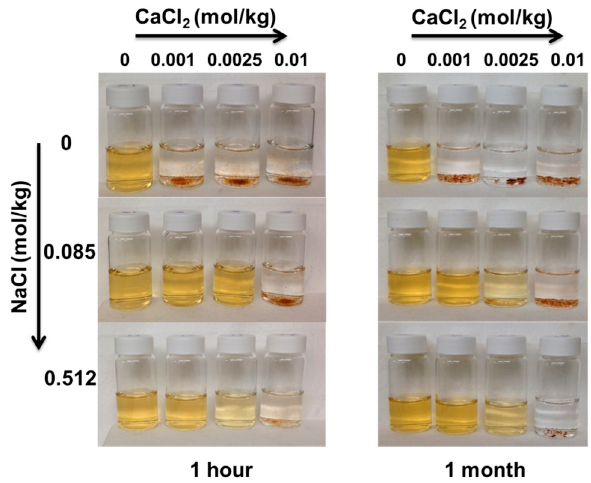
Figure 9. Effect of the electrolyte concentration and Ca 2+ adsorption on the stability of a PAA-MNPs’ suspension of concentration 0.01 g/L.